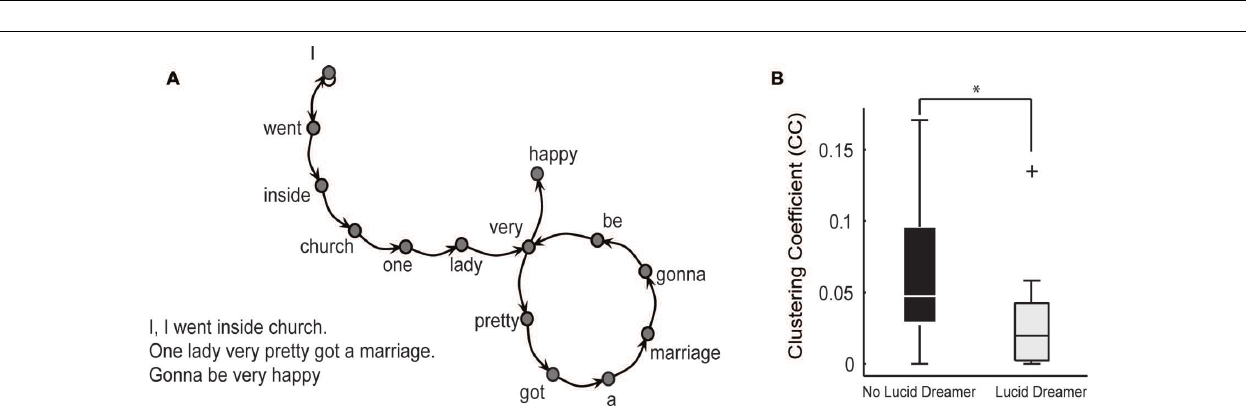
FIGURE 3 | Psychometric differences between lucid dreamers and non-lucid dreamers among schizophrenia patients. (A) Boxplots showing total BPRS of lucid dreamers and non-lucid dreamers in the S group ( p = 0.5930). (B) Boxplots showing total PANSS of lucid dreamers and non-lucid dreamers in the S group ( p = 0.6434). (C) Among S subjects, lucid dreamers showed higher scores on PANSS item N2 about emotional retraction ( p = 0.0329), without significant differences for the other symptoms; no significant differences were found among B subjects (see Supplementary Table 1) ( ∗ p < 0.05).